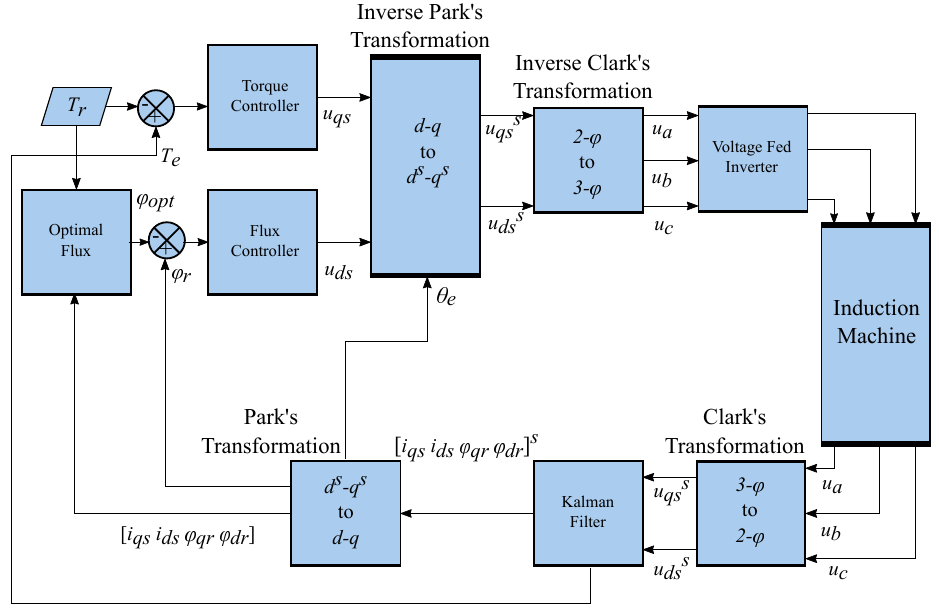
Figure 3. RFOC architecture for the IM